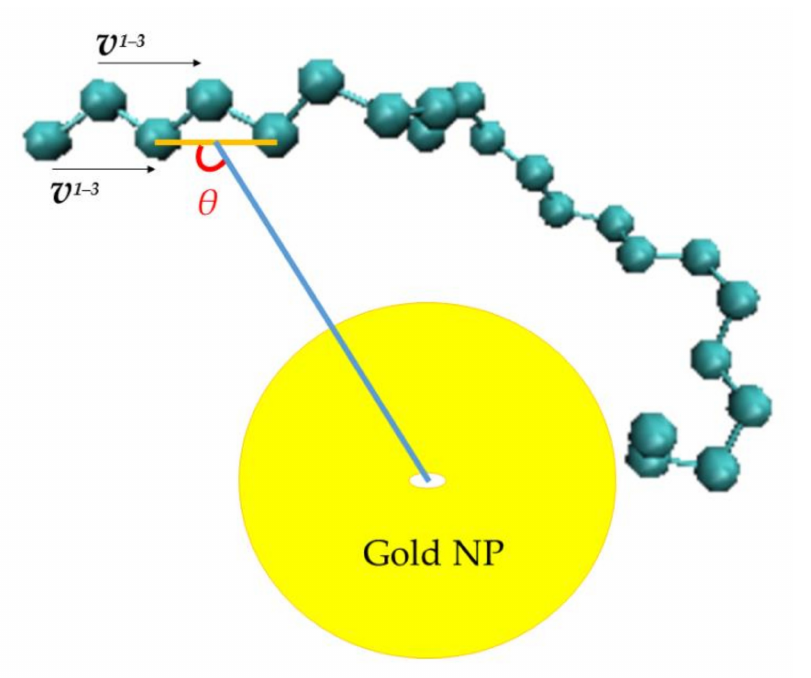
Figure A3. The definition of the θ angle for the calculation of the second rank bond order parameter S 1–3 of polyethylene chains for v 1 − 3 vector. In blue is the PE and in yellow is the Au NP. The orange line connects two non-consecutive carbon atoms and the blue line connects the center of the gold NP with the midpoint of the orange line. In red is the θ angle.